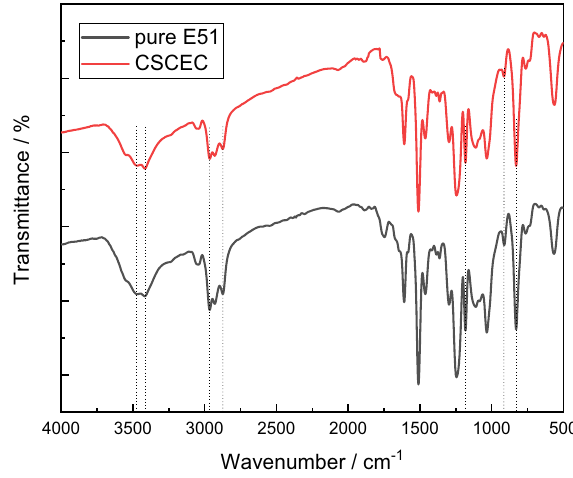
Figure 2. FTIR spectra of curing systems of pure E51 and CSCEC.